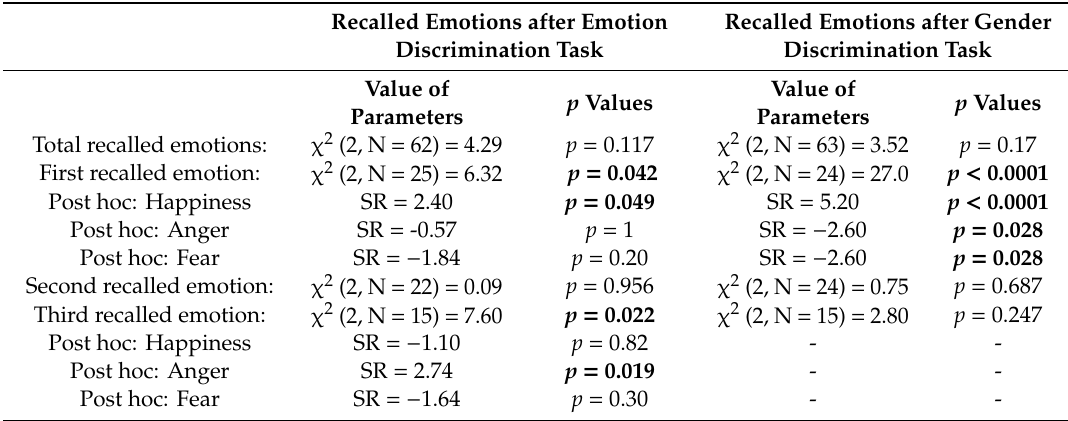
Table 5. Results of the Chi-squared goodness-of-fit test ( χ 2 ) of recalled emotion frequencies in the first, second, and third place of recalling. Standardized residuals (SR) were used to compute p -values for the post hoc tests. Statistically significant results are reported in